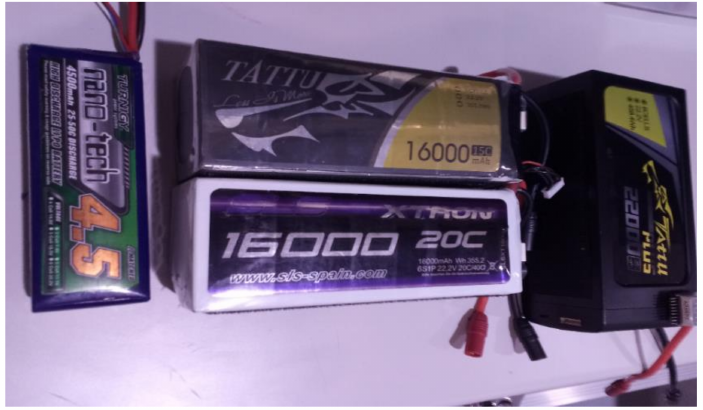
Figure 10. Different batteries used in power tests (discharge/charge).